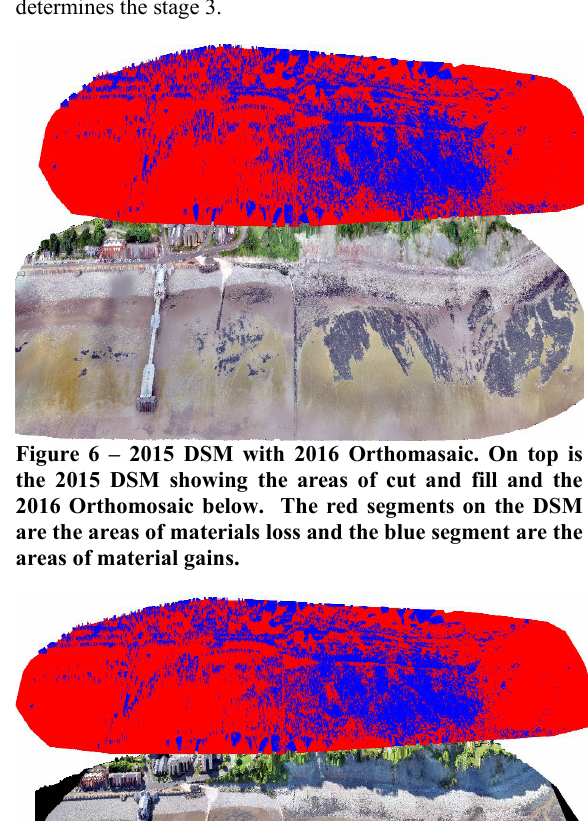
Figure 9b Penarth UAV 3D Photogrammetric Model